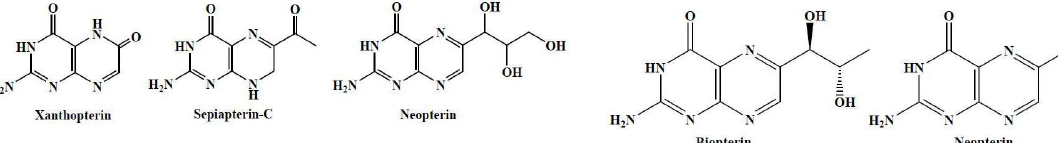
Figure 5: Redox active natural